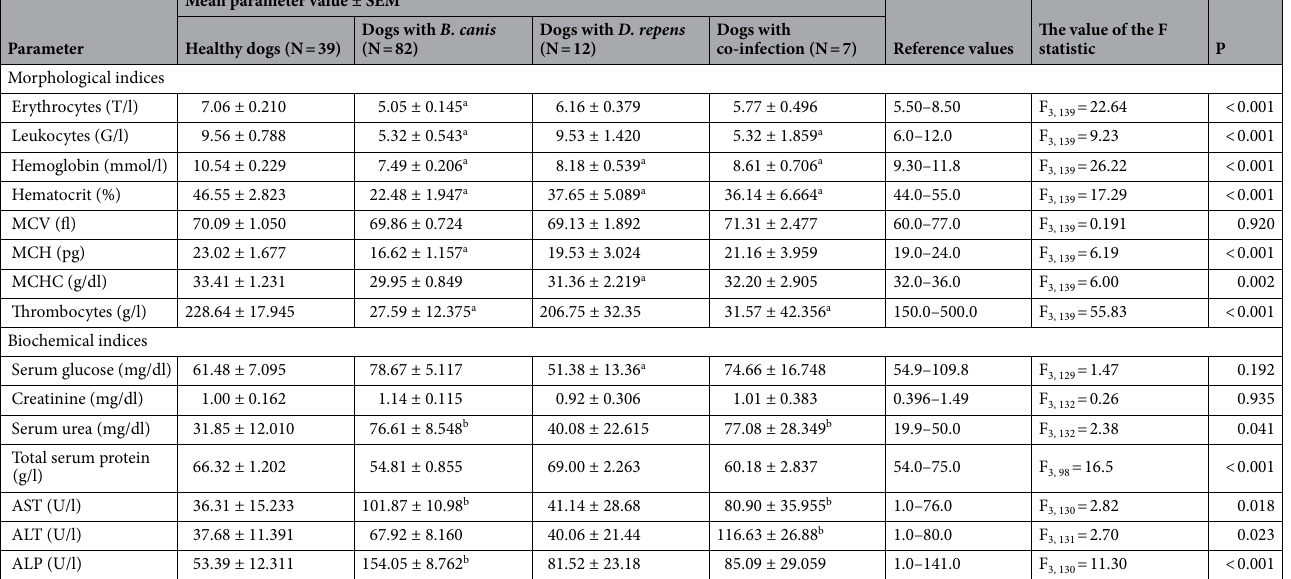
Table 1. Comparison of blood parameters between healthy dogs, infected with one parasite, and dogs with co-infection. a Decreased blood parameters. b Increased blood